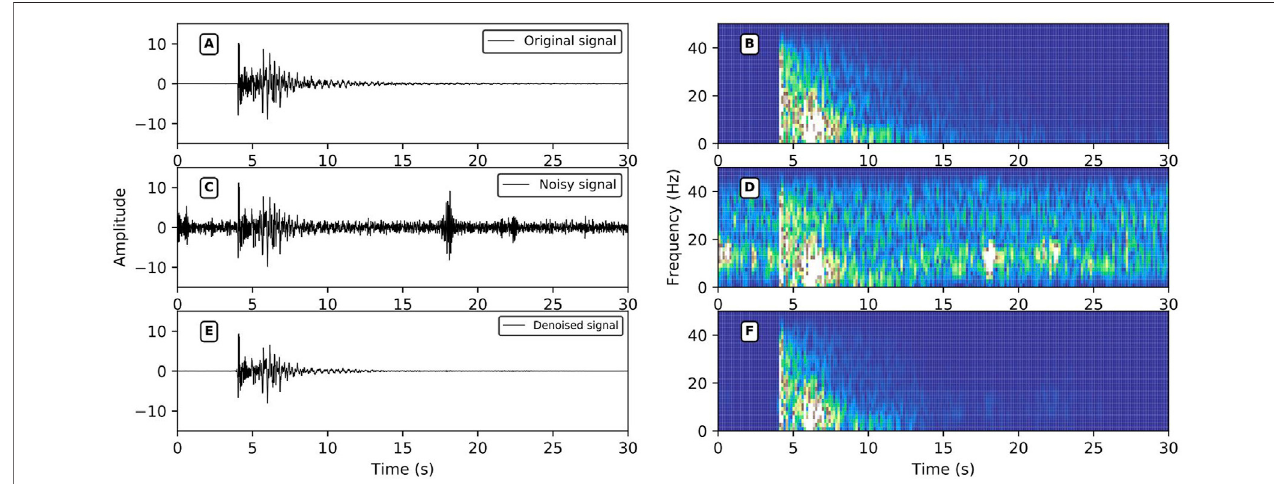
FIGURE 10 | Broadband noise reduction performance. (A,C,E) are the original signals, the noise signal, and the signal after noise reduction in the time domain; (B,D,F) are the time-frequency domain data of (A,C,E) ; the signal SNR after adding noise (cid:1) − 0.52 dB, r (cid:1) 0.6902, SNR after noise reduction (cid:1) 9.78 dB, r (cid:1) 0.9595.